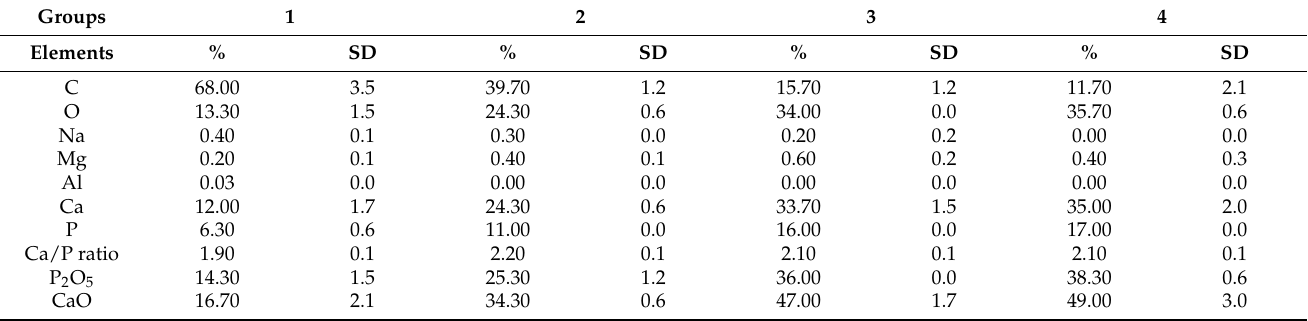
Table 3. Chemical composition results obtained by energy dispersive X-ray spectroscopy.